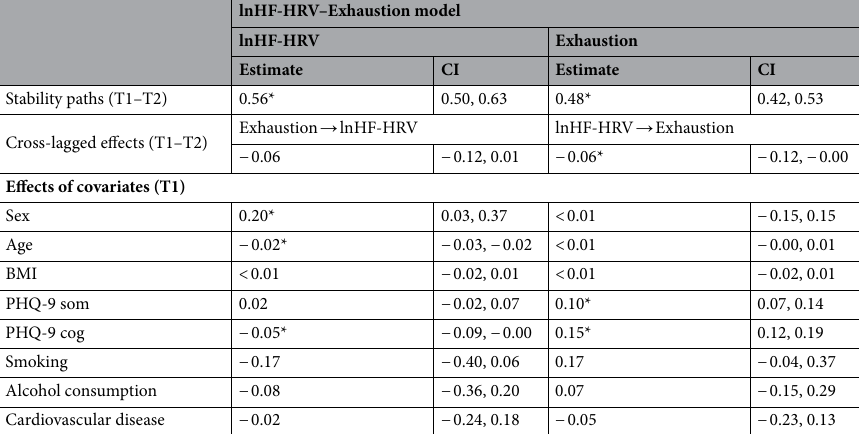
Table 3. Path coefficients of cross-lagged panel models on exhaustion symptoms and lnHF-HRV with covariates. Sex is coded 0 = male, 1 = female; BMI = body mass index; Cardiovascular Disease = self-reported hypertension and/or cardiac arrhythmias; CI = confidence interval; lnHF-HRV = high frequency heart rate variability, logarithmized; PHQ-9 cog = Patient Health Questionnaire 9—cognitive factor; PHQ-9 som = Patient Health Questionnaire 9—somatic factor; T1 = first attended measurement time point; T2 = measurement time point with the largest time-lag to T1. *CI does not include